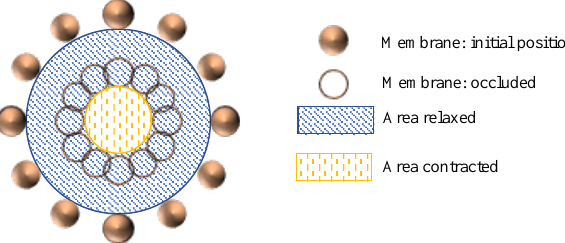
Figure 5. Representation of how the occlusion degree is defined.